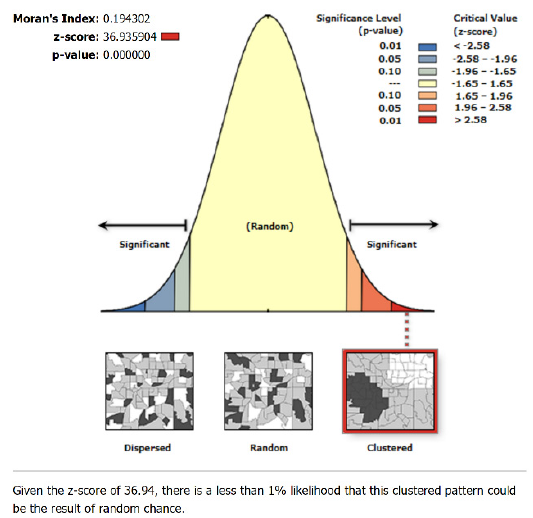
Figure 11. The spatial autocorrelation result of the clustered data.